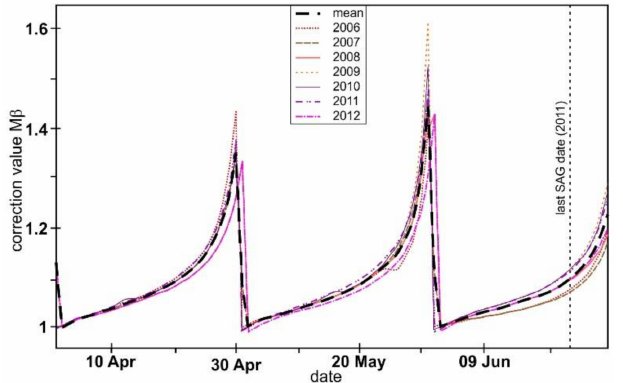
Figure A2. Observed snow surface correction values for WY2007–2012 (color lines) and approximated surface correction value used for WY2013–2019 (black line) over ablation season (April, May, and June). Vertical dashed line is the latest observed date of SAG (WY2011) for the period.